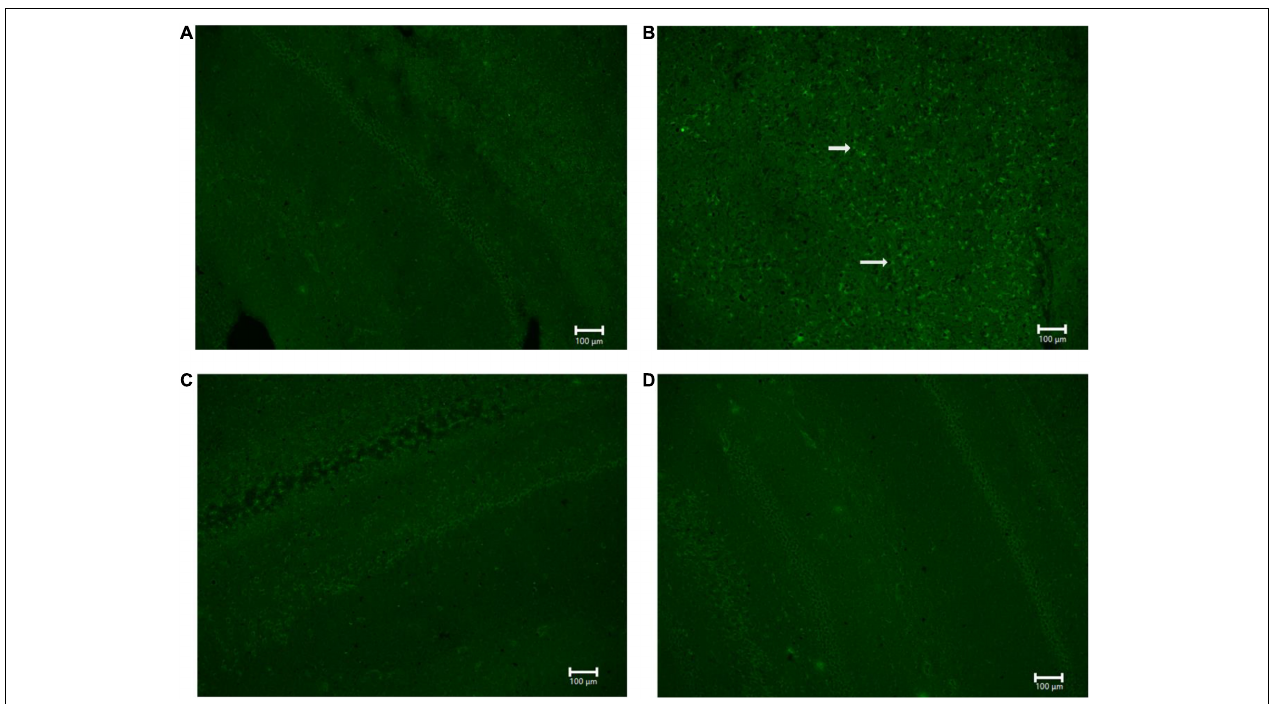
FIGURE 8 | Analysis of neurodegeneration using Fluoro-Jade C. Sprague Dawley rats underwent MCAO procedure and the posteromedial cortical amygdala examined for Fluro-Jade C positive cells (A) no MCAO + saline (control); (B) MCAO + saline (positive control); (C) MCAO + 100 µ g/kg NG291; (D) MCAO + 100 µ g/kg of NG291 every 24 h for 3 days. Transcardial perfusion was performed on the third day after the initial treatment for conditions (A–C) . Animals in condition (D) were perfused 1 h after the third NG291 dose. Brains were sectioned coronally with 20 µ m of thickness. Keyence BZ-X800 fluorescence microscope was used to detect positive Fluoro-Jade C cell staining. Panels (A–D) were imaged at 10 × under the same conditions. White arrows indicate positive staining for Fluoro-Jade C. Scale bar = 100 µ